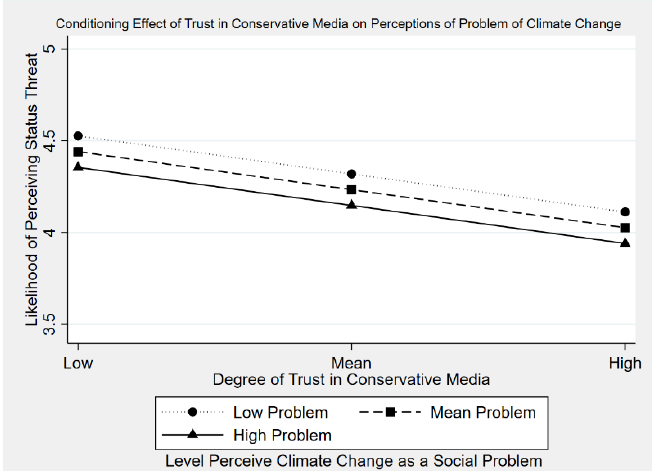
Figure 2. Conditioning Effect of Conservative Media: Climate Change and Status Threat.